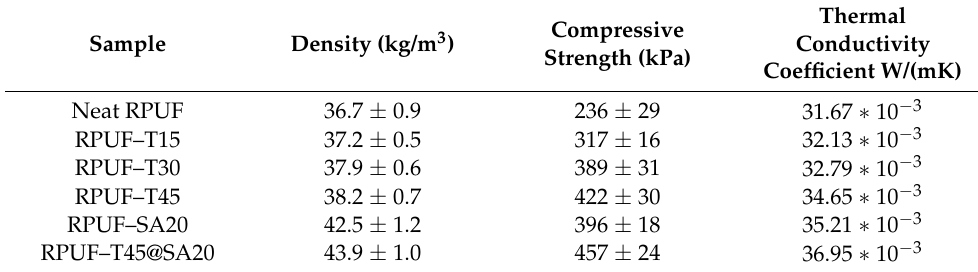
Figure 6. SEM images of neat RPUF ( a ), RPUF–T15 to RPUF–T45@SA20 ( b – f ). Table 2. Density, compressive strength and thermal conductivity of